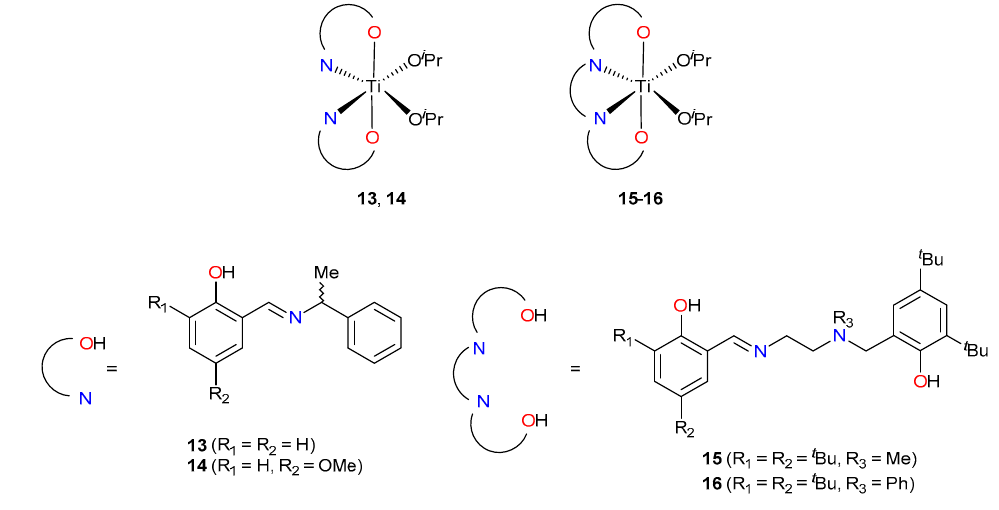
ff -base complexes 13–16 [39,40]. Figure 3. Ti-Schiff-base complexes 13–16 Figure 3. Ti-Schiff-base complexes 13–16 [39,40]. Figure 3. Ti-Schi